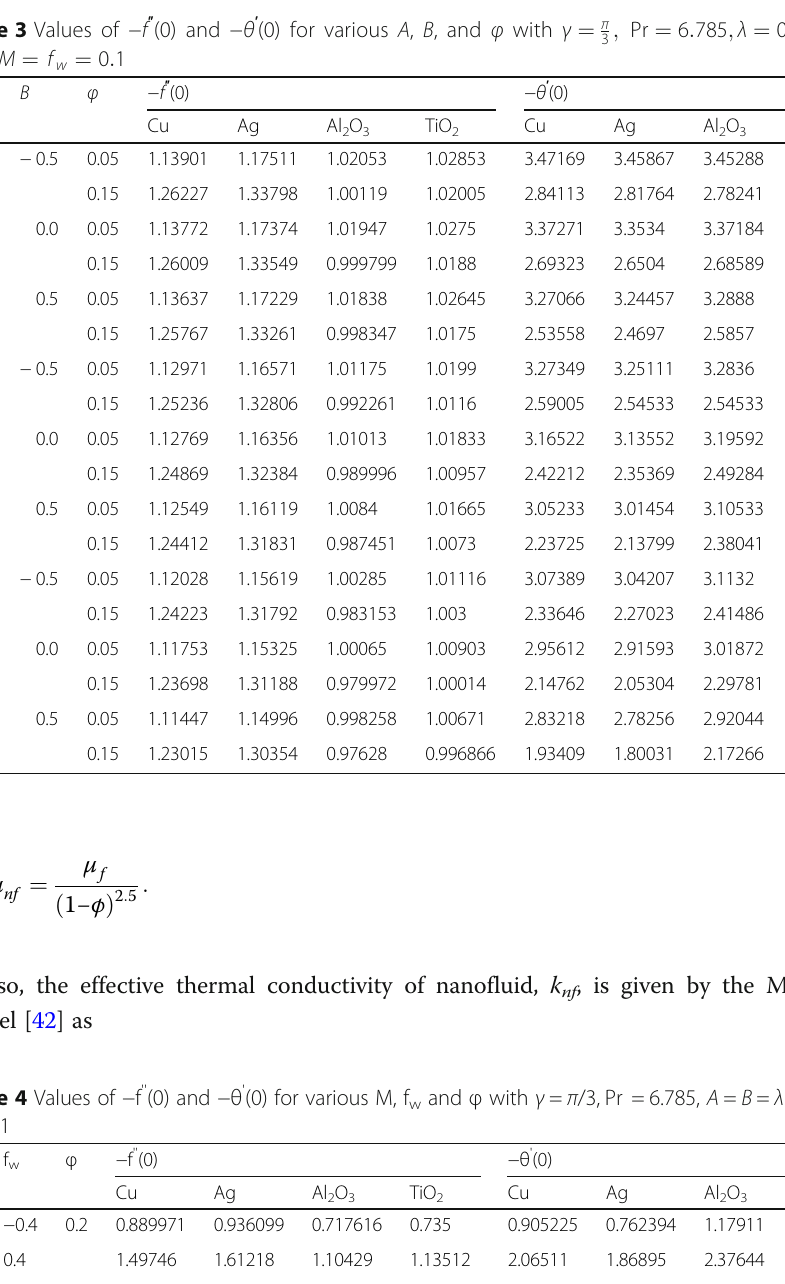
Table 3 Values of − f ″ (0) and − θ ′ (0) for various A , B , and φ with γ ¼ π